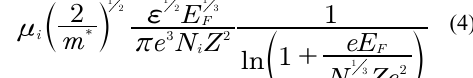
Ca O thin films for band 0.85 0.15